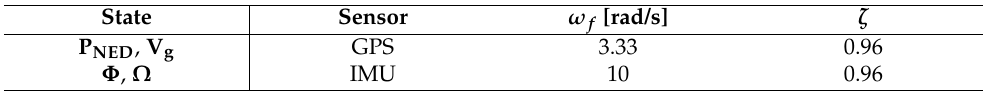
Table 4. Configuration for Low-pass filter.